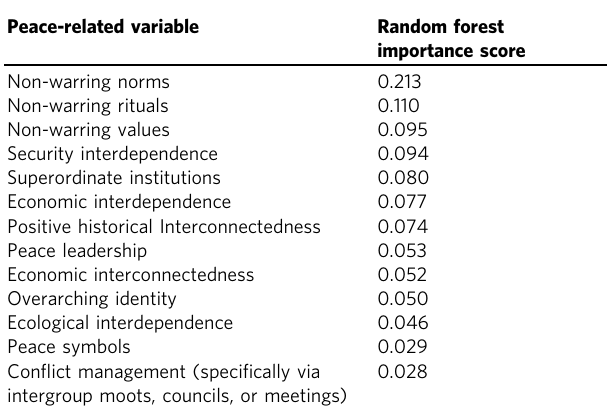
Table 4 Random forest machine learning assessment of peace-related variables as to their relative importance for a peace system outcome.